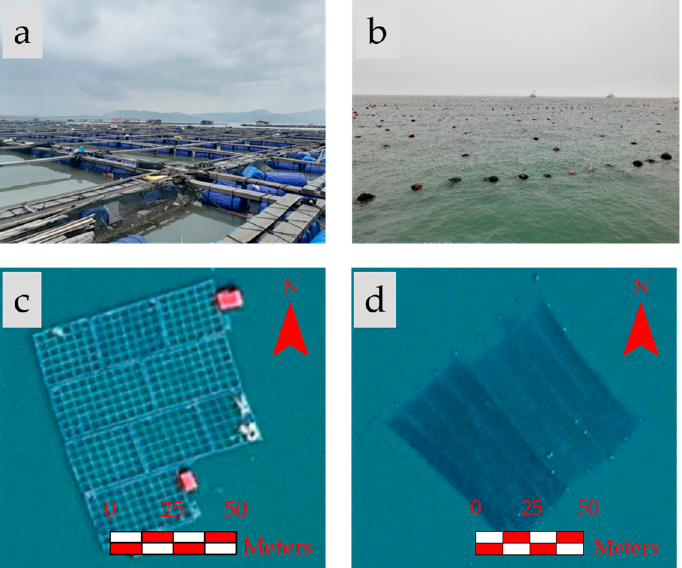
Figure 2. Photography of cage ( a ) and raft ( b ). Level 19 remote sensing image of cage ( c ) and raft ( d ) in Google Earth.